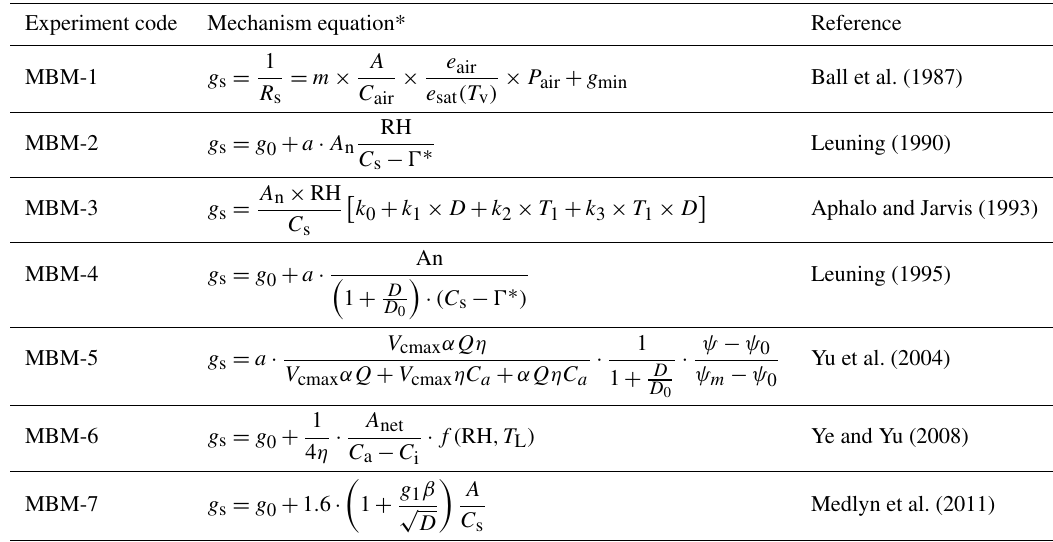
Table 1. The coupled stomatal conductance and resistance equation lists.